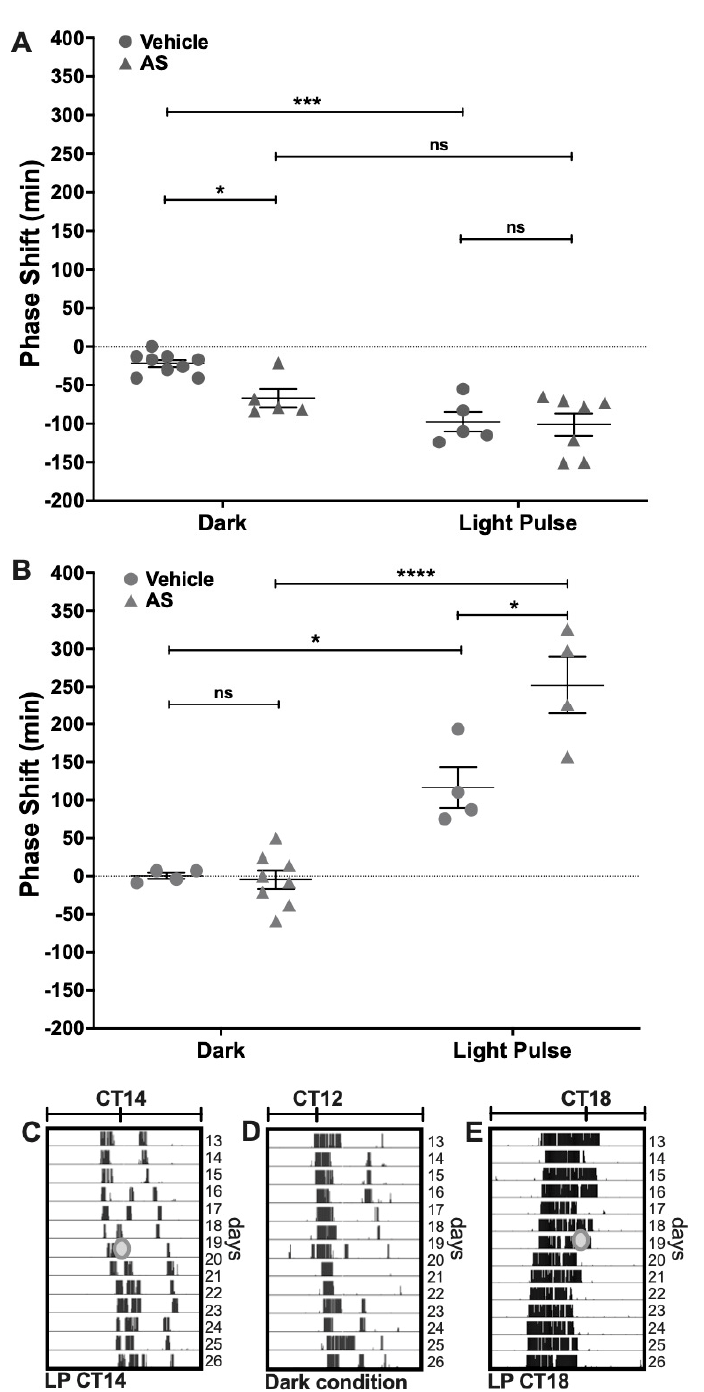
Figure 1. Effect of the nitroxyl donor AS on phase changes induced by light. Hamsters in constant darkness conditions, treated with an i.c.v injection of vehicle or 100 μ M AS, 5 min before a subsaturant light pulse (LP, 10 min, 50 lux) at two CTs: ( A ) CT14 and ( B ) CT18. Control animals (Dark) received only pharmacological treatment without the light pulse. Phase changes are shown as mean ± SEM. Two-way ANOVA, followed by Tukey’s multiple comparisons test, ns = not significant; * p < 0.05; *** p < 0.001; **** p < 0.0001. CT14 Dark: Veh n = 9, AS n = 5; CT14 LP: AS + LP n = 7, Veh + PL; CT18 Dark: Veh n = 4, AS n = 7; CT18 LP: Veh + LP and AS + LP n = 5. ( C – E ) are representative actograms showing: ( C ) the effect of a light pulse at CT14, inducing a phase-delay in the circadian locomotor rhythms; ( D ) the phase of an animal without light stimulation during the subjective night; and ( E ) the effect of light stimulation at CT18, which induces a phase-advance. The grey circle indicates the day and time of the LP.